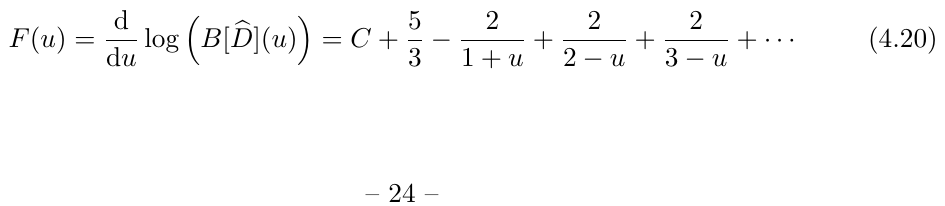
and, upon expansion, predicts the series coe(cid:14)cients for the Borel transform with un- precedented precision for coe(cid:14)cients up to c 0 : 8% ; 6% ; 2% ; 3% ; 2% ; 1% ; 1% for the coe(cid:14)cients c